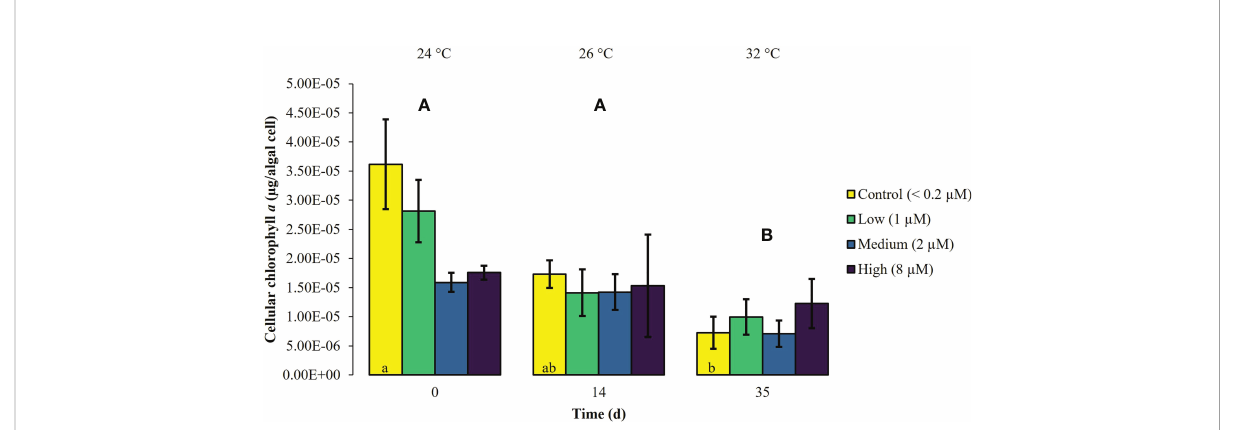
FIGURE 3 Cellular chlorophyll a ± SEM of Xenia umbellata colonies (n = 3) kept at different phosphate concentrations (control < 0.2 m M; low ~ 1 m M; medium ~ 2 m m; high ~ 8 m M) and exposed to an arti fi cially induced water temperature increase. Bars represent the mean of three replicates. Different capital letters above bars indicate signi fi cant differences between days and different letters within bars show signi fi cant differences within treatments over time (pwc, Bonferroni adjustment, pairwise t-test, p <